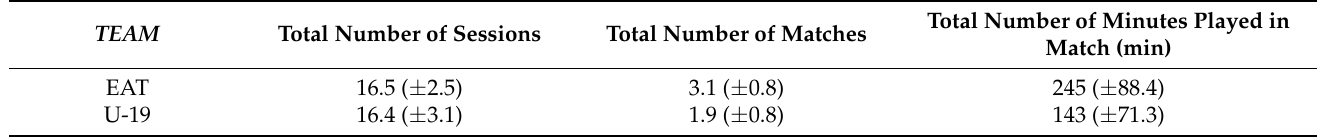
Table 2. Summary of match and training volume for both